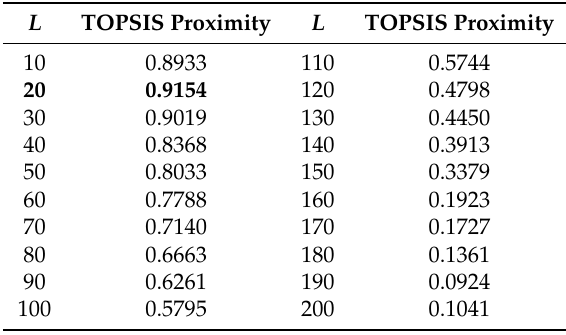
Table 3. Technique for Order of Preference by Similarity to Ideal Solution (TOPSIS) proximity under different hidden layer node